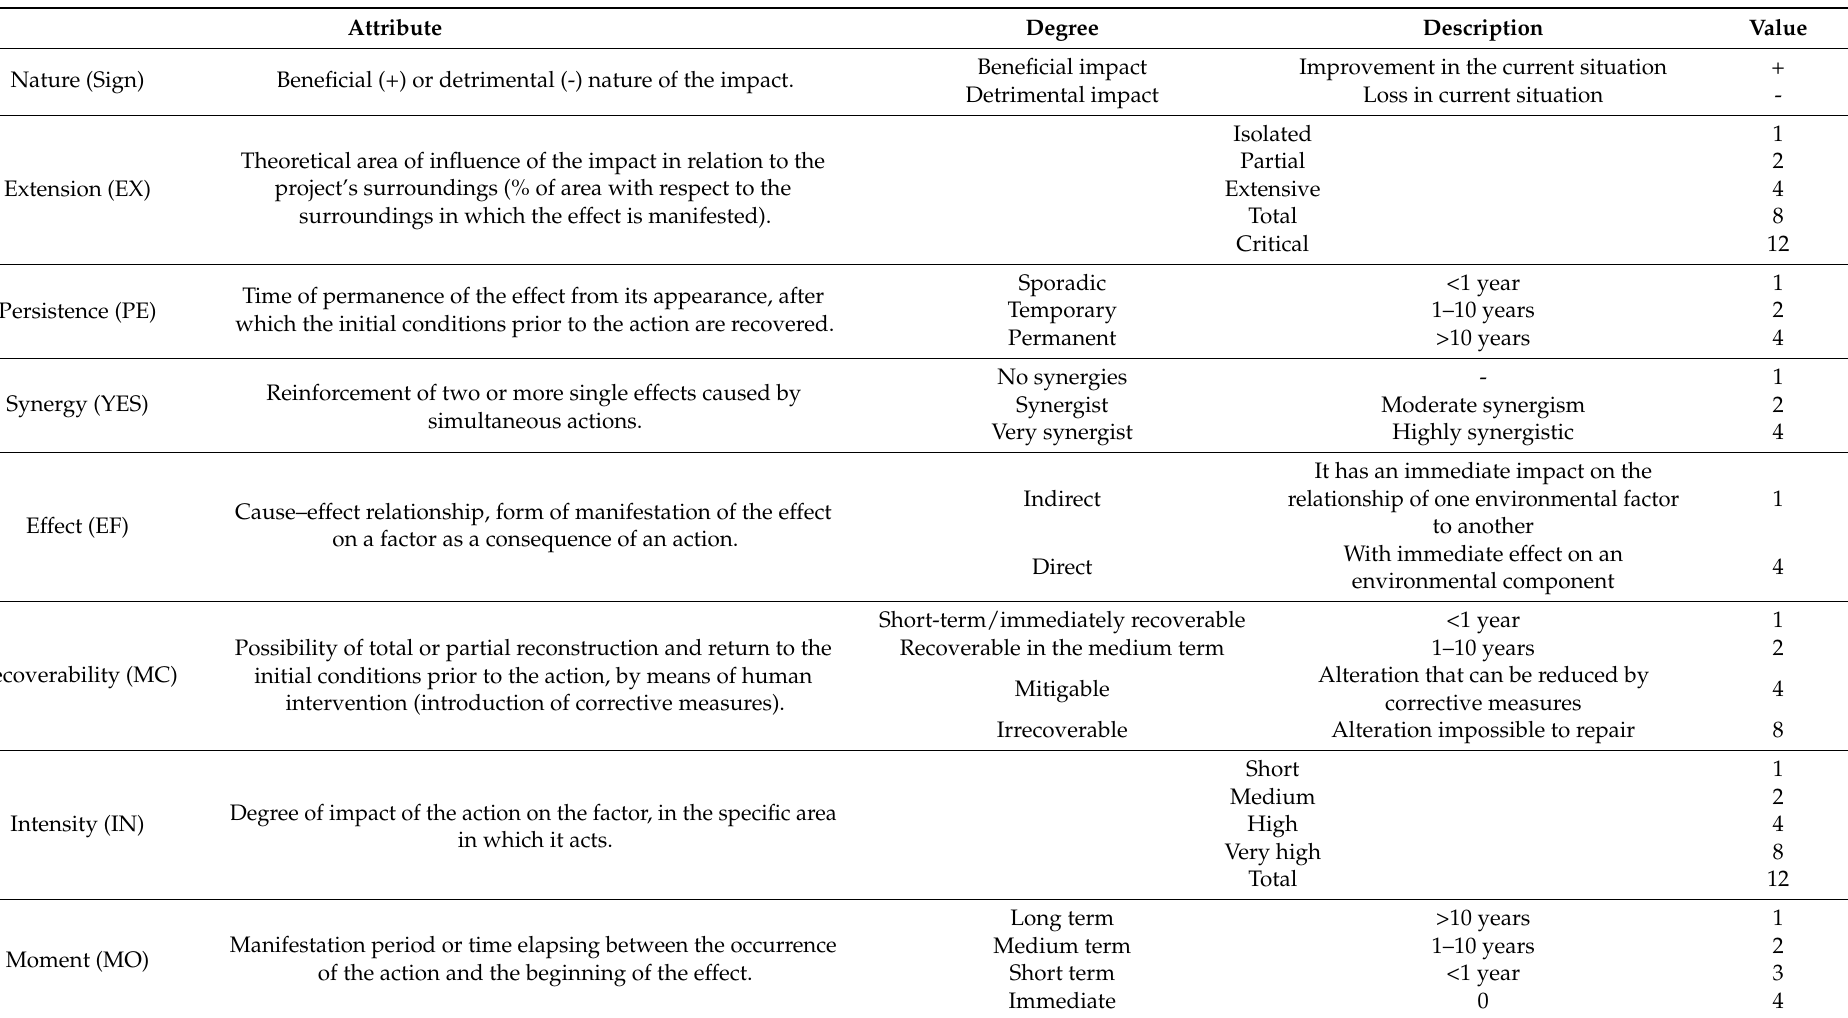
Table 1. Impact classification